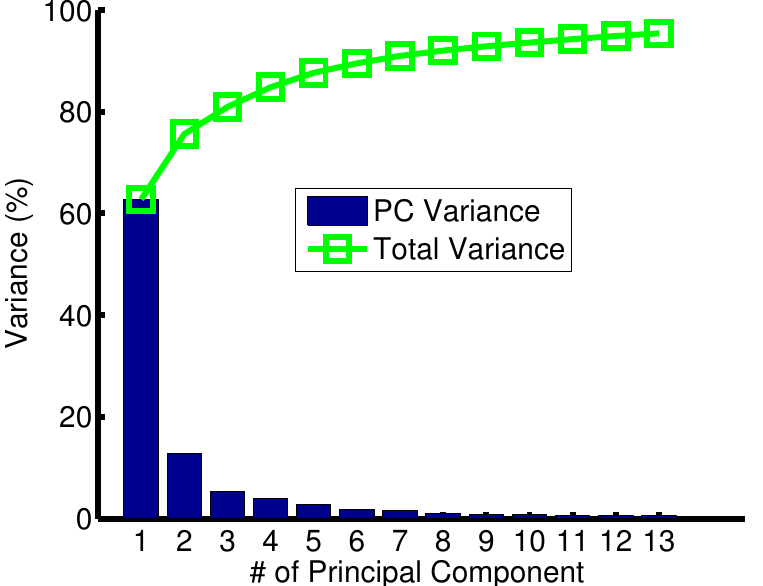
Figure 6. Variance cumulative sum for the first 13 principal